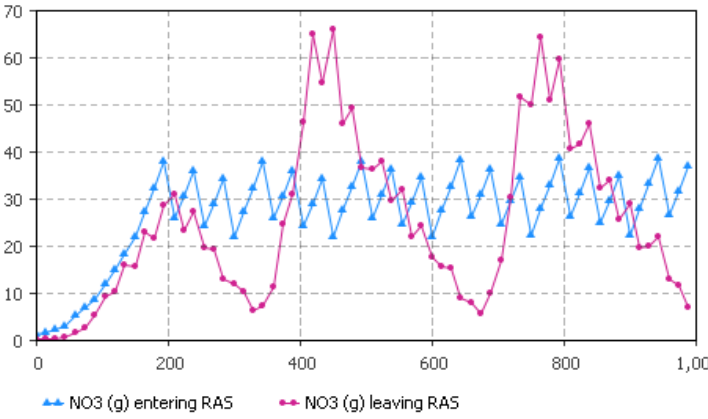
Figure 14. The evapotranspiration dependency for the water flow (in L; y ‐ axis) from RAS to the hydroponic component can be seen clearly in this figure showing the flow from the RAS to the hydroponic component under natural light conditions. The days are displayed on the x ‐ axis.